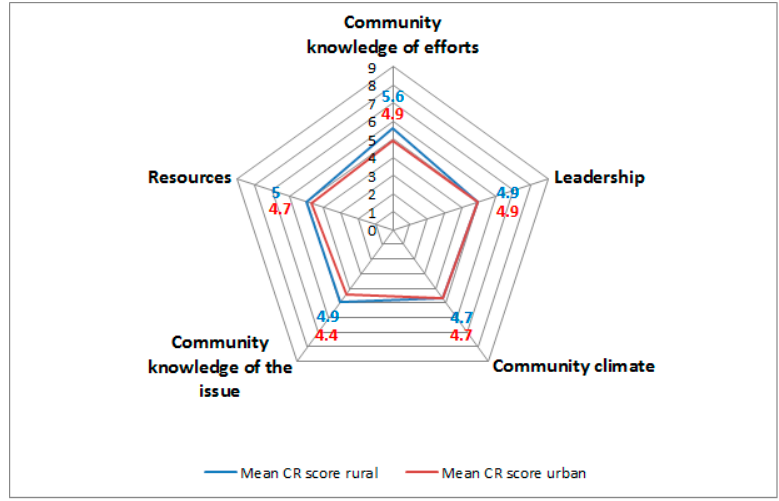
Figure 1. Cobweb chart showing average community readiness (CR) score per dimension for rural and urban communities.